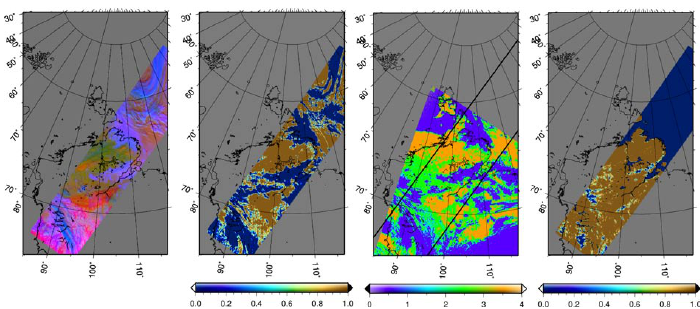
Figure 13. Northern part of Russia. AATSR: 21 April 2006, 05 h 13'21'', orbit number 21644. MODIS: 21 April 2006, 05 h 40'. Left panel is the false color composite (red is 11µm BT, green is 550nm reflectance, blue is 1.6 µm reflectance) of initial AATSR scene; second left panel is the clear snow mask of AATSR scene (0 – not snow, 1 – clear snow) achieved with presented method; third left panel is MODIS cloud mask: 1 – cloudy, 2 – probably cloudy, 3 – probably clear, 4 – clear; right panel is operational AATSR cloud mask from level-0 product: 0 – cloudy, 1- clear.